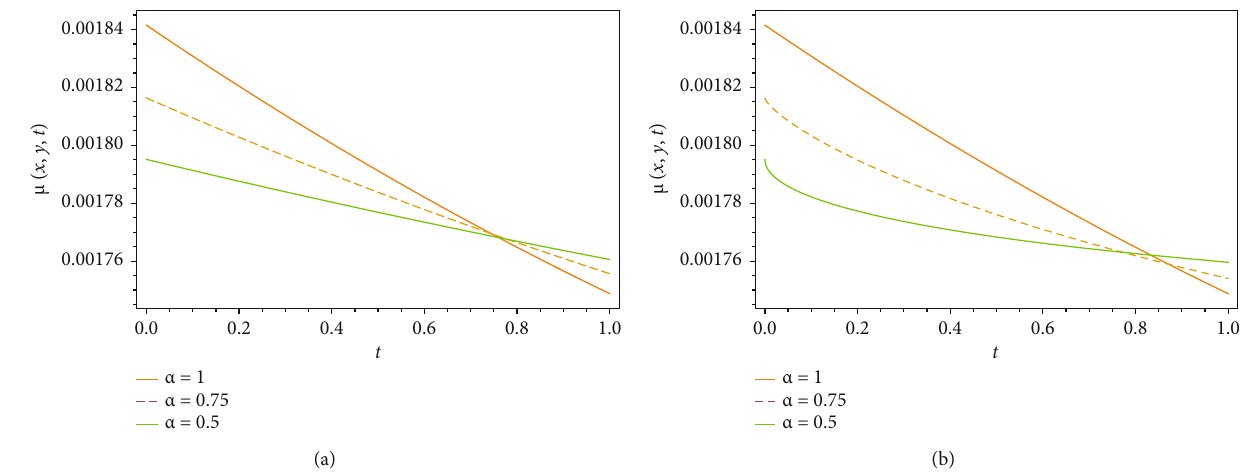
Figure 3: (a) NTDM and (b) NTDM of Example 1, for x = 0 : 5 , ζ = 0 : 5 , and λ = 0 : 001 for di ff erent values of μ CF ABC